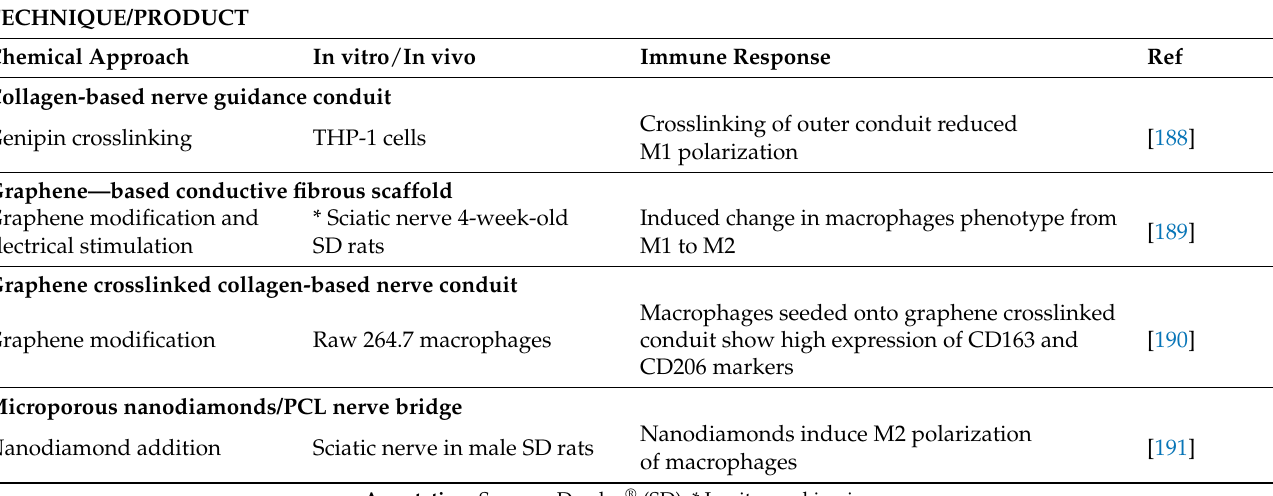
Table 2. Chemical modifications for the polarization of macrophages during